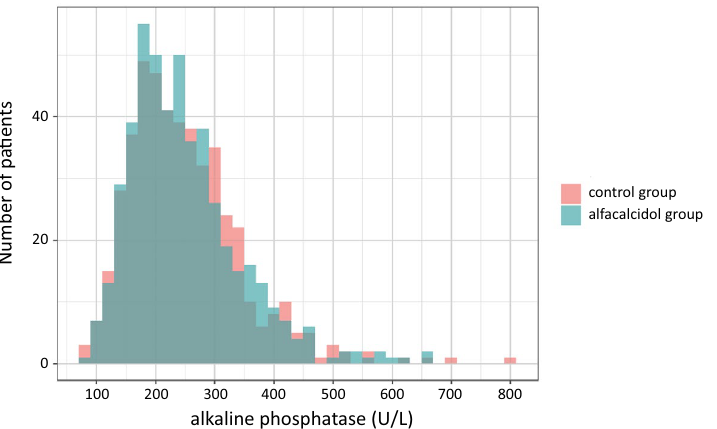
Figure 1. Histogram of baseline total alkaline phosphatase levels among 976 randomized patients. A total of 495 patients in the alfacalcidol group (blue) and 481 patients in the control group (red). The median [25–75th percentile] baseline alkaline phosphate level was 234 [183–296] U/L.